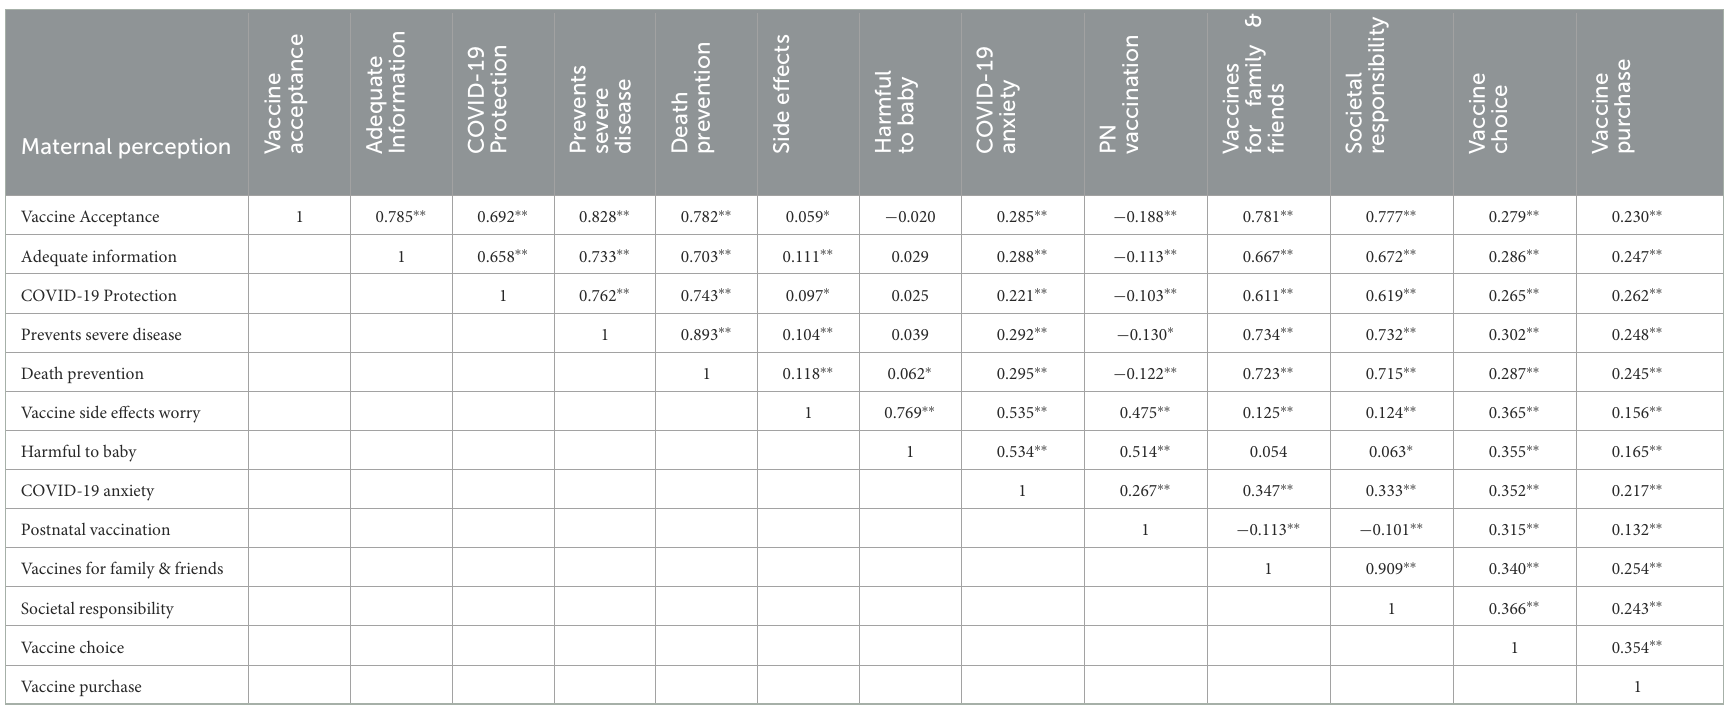
TABLE 5 Spearman’s correlation between maternal perceptions and attitudes toward COVID-19 vaccination.